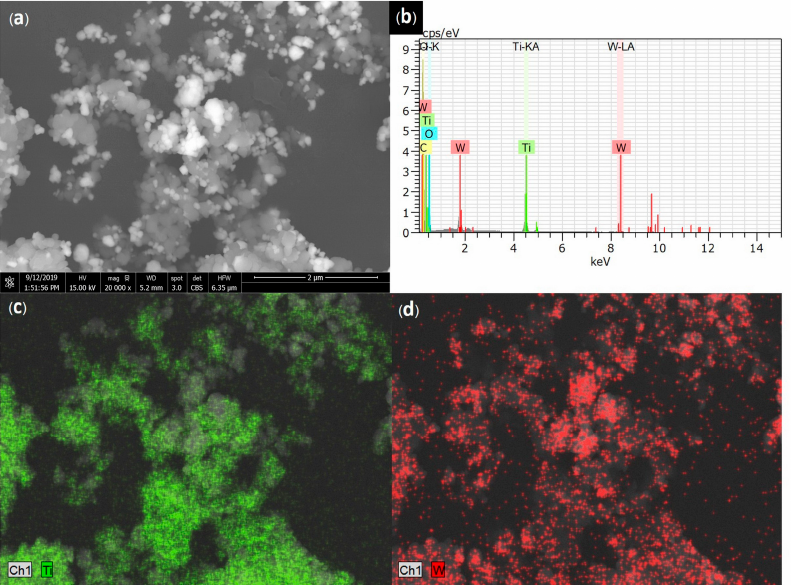
Figure 8. SEM image ( a ), EDX spectrum ( b ), and EDX dot maps ( c , d ) of the mixed metal oxides (TiO 2 /WO 3 /PTh).